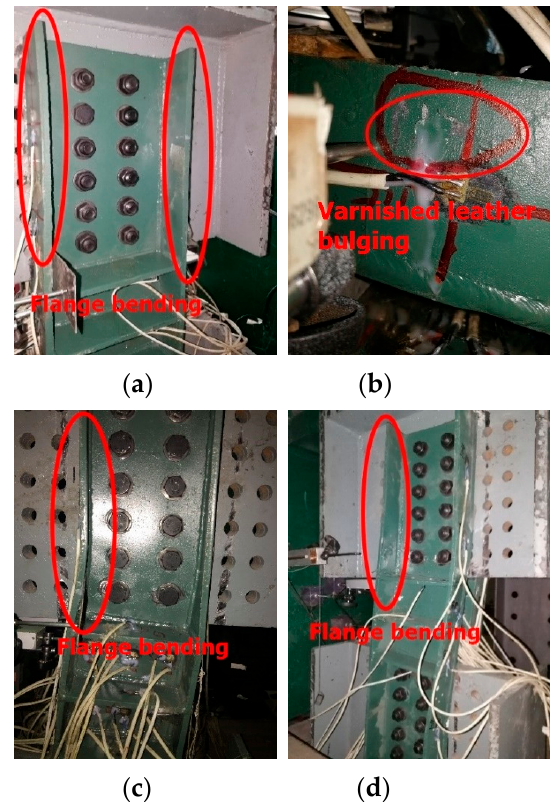
Figure 8. Failure modes of RSL-4. ( a ) flange bending; ( b ) vanished leather bulging; ( c ) flange bending; ( d ) flange